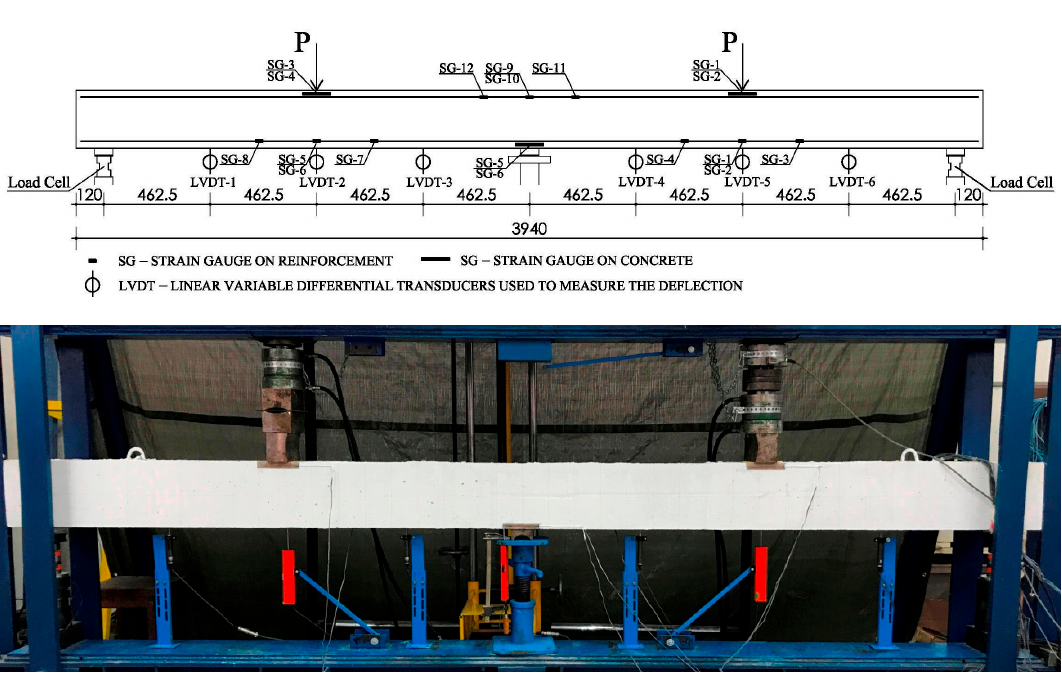
Figure 3. Equipped continuous beam before testing (dimensions in mm).